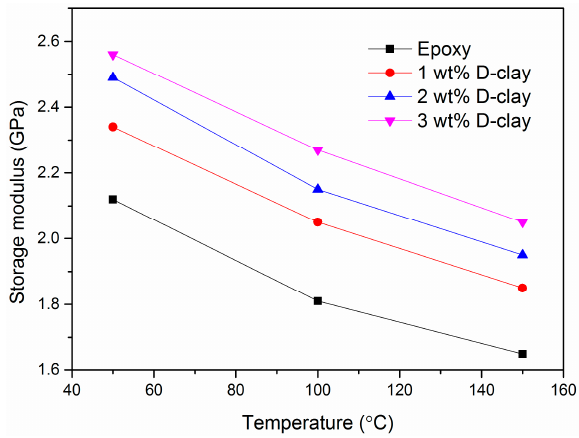
Figure 7. Storage modulus of D-clay epoxy at different weight loading, measured by dynamic mechanical analysis (DMA).